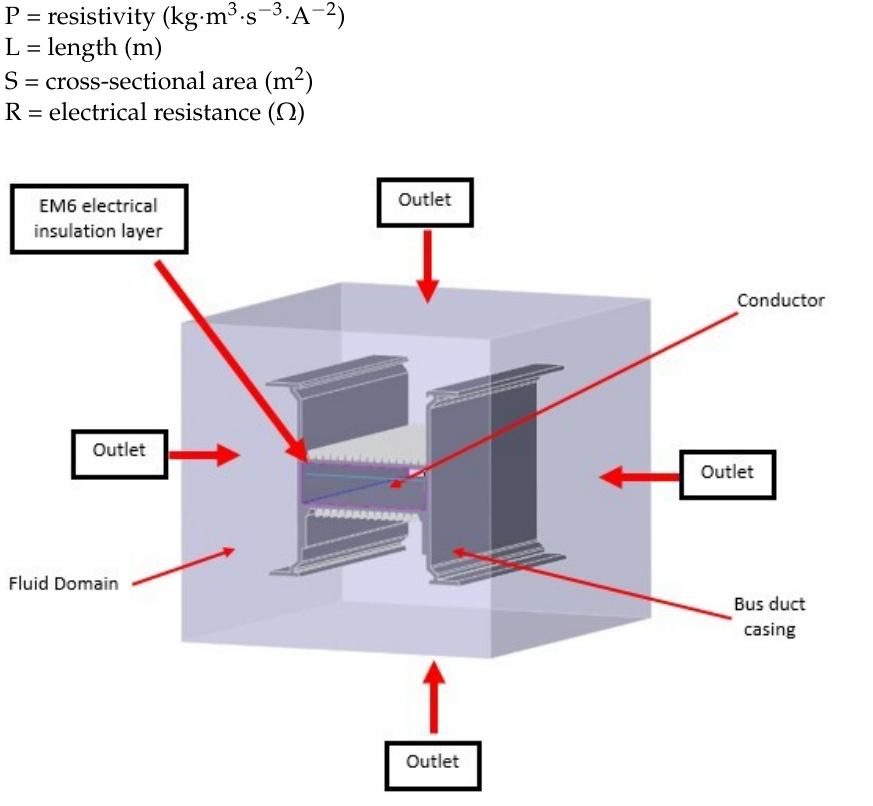
Figure 3. Boundary Conditions .